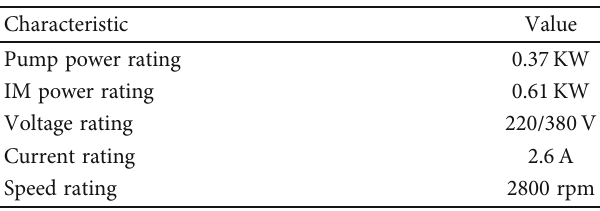
Table 2: Motor-pump characteristics.